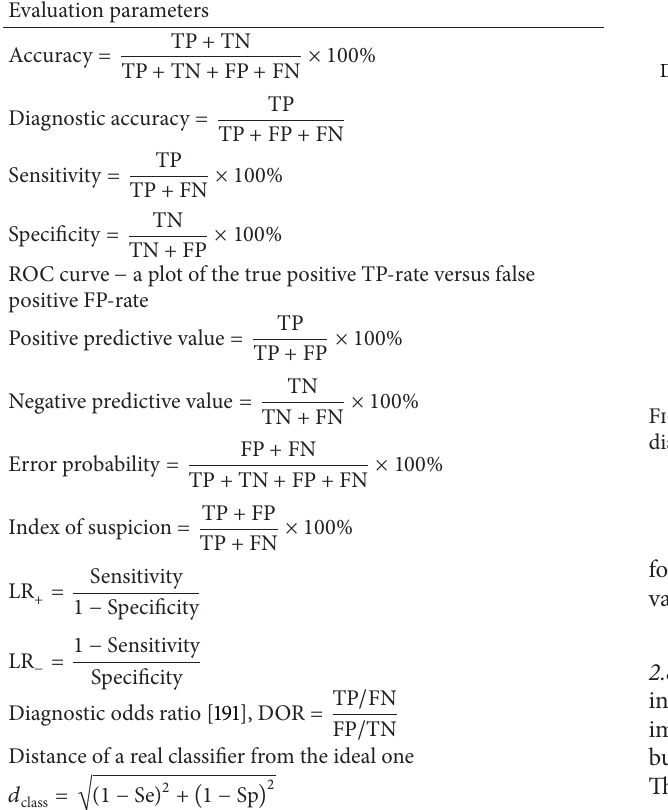
Table 3: Measures for evaluating performance of a classifier.